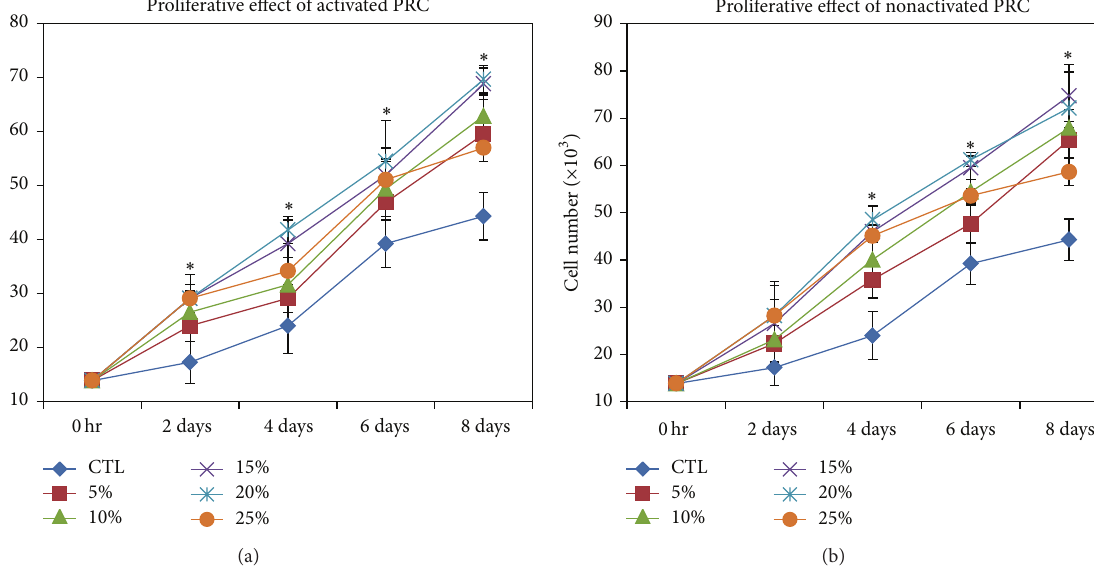
Figure 4: Effect of different concentrations of activated (a) and nonactivated PRC (b) on hMSC proliferation. Significant difference was observed between control and 15% activated PRC treated group at 2, 4, 6, and 8 days, while for the 15% nonactivated PRC group, the same was observed only from day 4 ( ∗ 𝑃 ≤ 0.05 ). There was no significant difference between 15% and 20% PRC treated